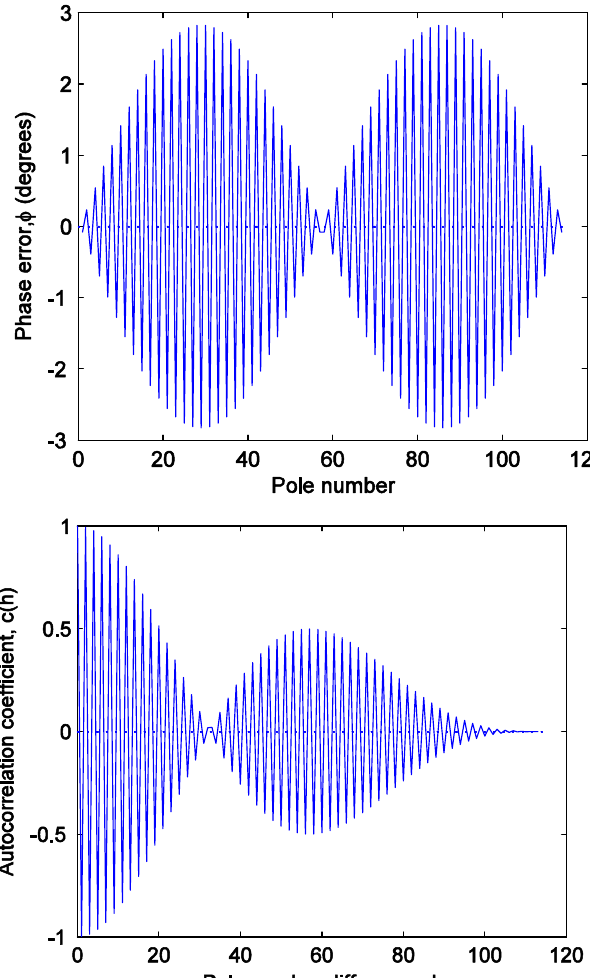
FIG. 5. Phase errors resulting from a sinusoidal trajectory angle error (upper) and the corresponding autocorrelation